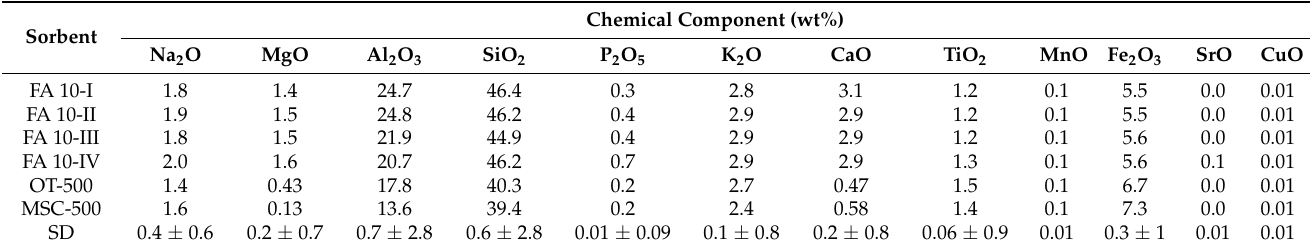
Table 5. Inorganic components of tested materials.